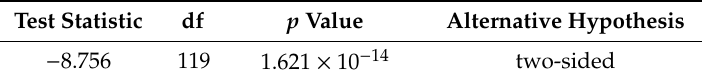
Table 2. The result of paired sample t